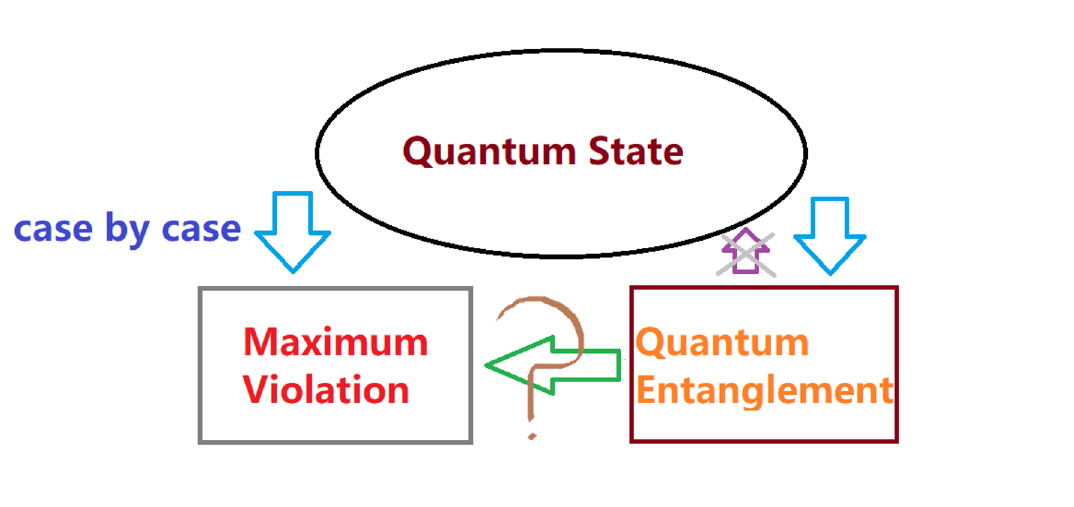
Figure 1 . We show the difficulties in demonstrating 3-qubit Quantum Entanglement from Mermin’s